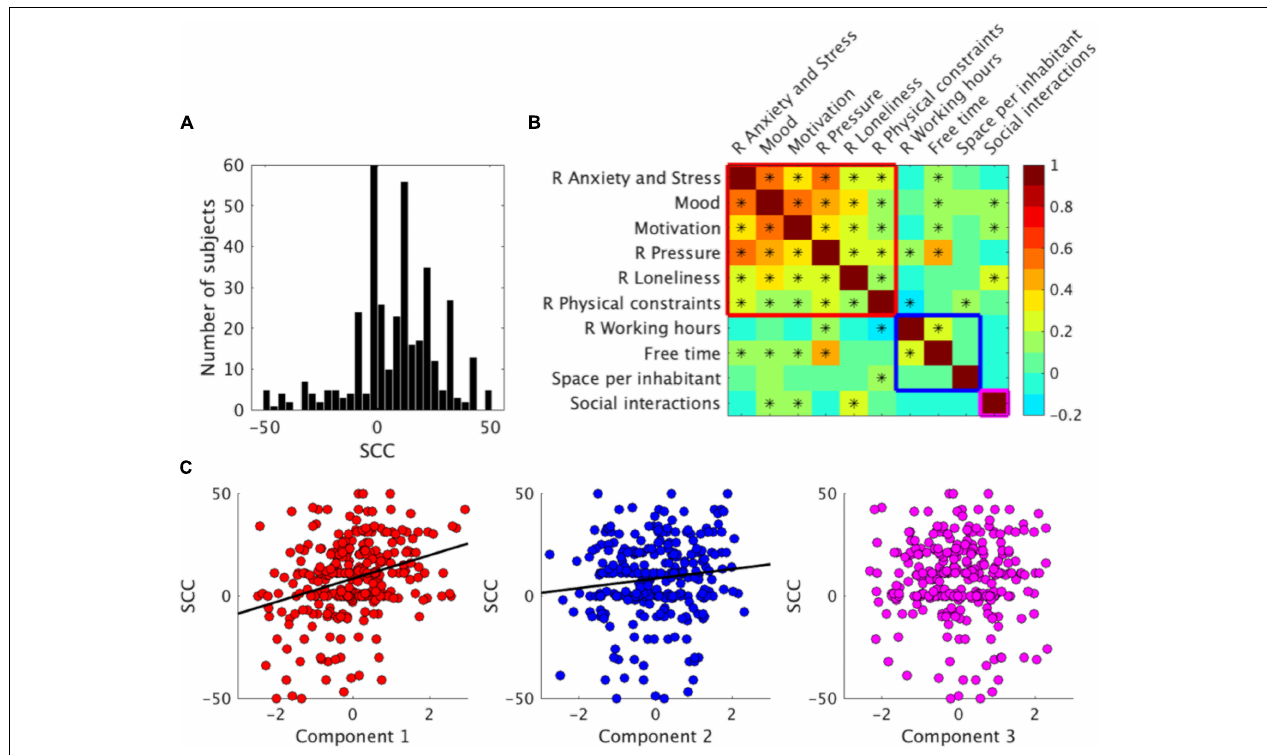
FIGURE 1 | Subjective creativity change (SCC) and subjective experience of the lockdown. (A) Histogram of SCC scores. (B) Correlation matrix between measures assessing the living conditions and subjective experience of the lockdown situation. Stars indicate p < 0.05. Cold to hot colors represent the Pearson correlation coefficient (r). R indicates that the measure’s sign was reversed for positive values as positive changes (improvement) for all variables. Colored squares group measures clustering on the three principal components (red: Component 1, blue: Component 2, magenta: Component 3). (C) SCC as a function of participant’s component loadings. One dot represents one participant, and bold lines indicate that the correlation between the principal component and SCC was significant (Pearson correlation, p < 0.05).